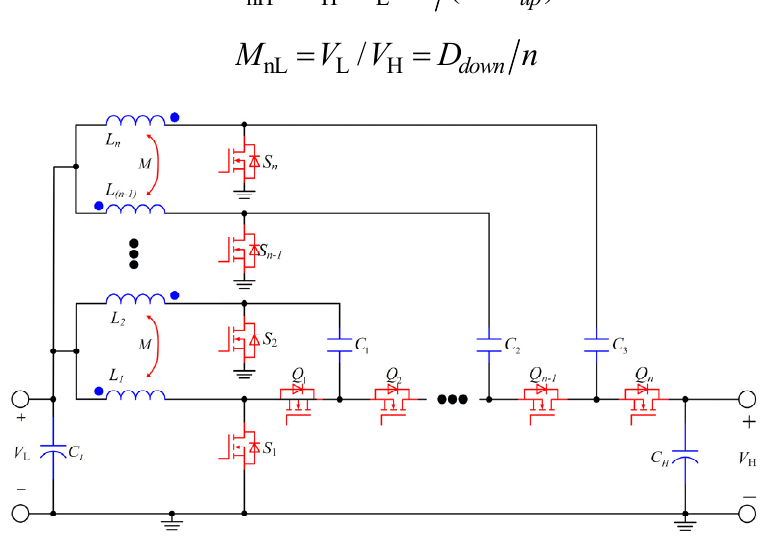
Figure 22. Extensible circuits based on the proposed